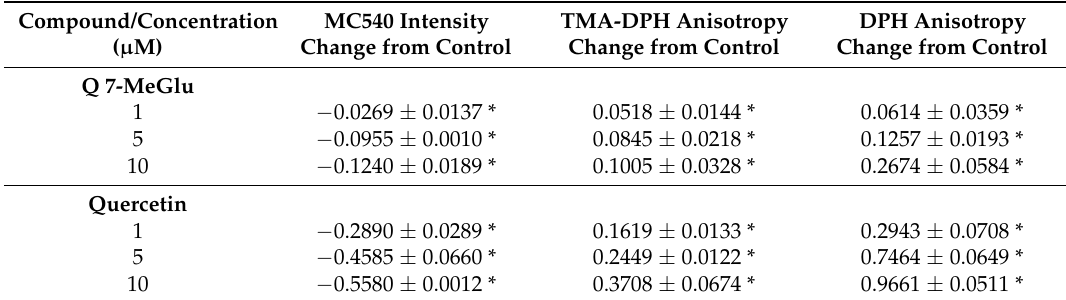
Table 1. Quenching changes in fluorescence intensity (for MC540 probe) and anisotropy (for TMA-DPH and DPH probes) in the presence of quercetin 7- O - β - D -(4”- O -methyl)glucopyranoside (Q 7-MeGlu) and quercetin (Q) used at concentration range 1–10 µ M in phosphatidylcholine liposomes (PC). Negative values indicate a decrease in fluorescence intensity as compared to control, while positive